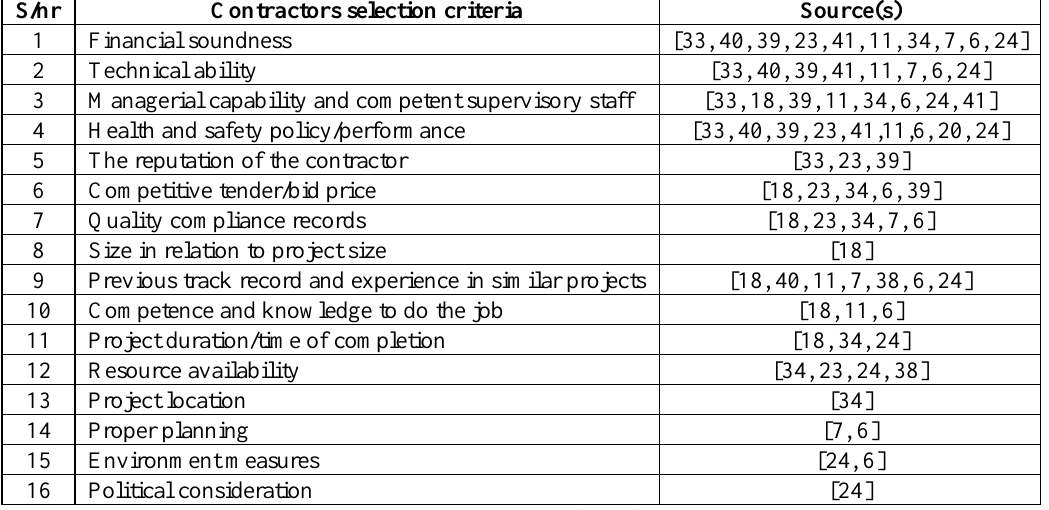
Table 1: Major contractors selection criteria on Civil engineering construction